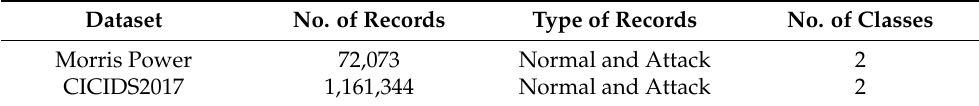
Table 1. The binary classification with